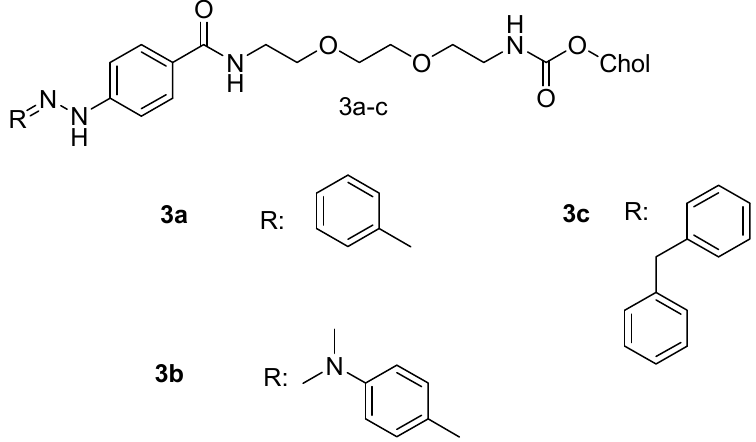
Figure 2. Chemical structures of cholesterol-based hydrazone tethered amphiphiles, compounds 3a – c .